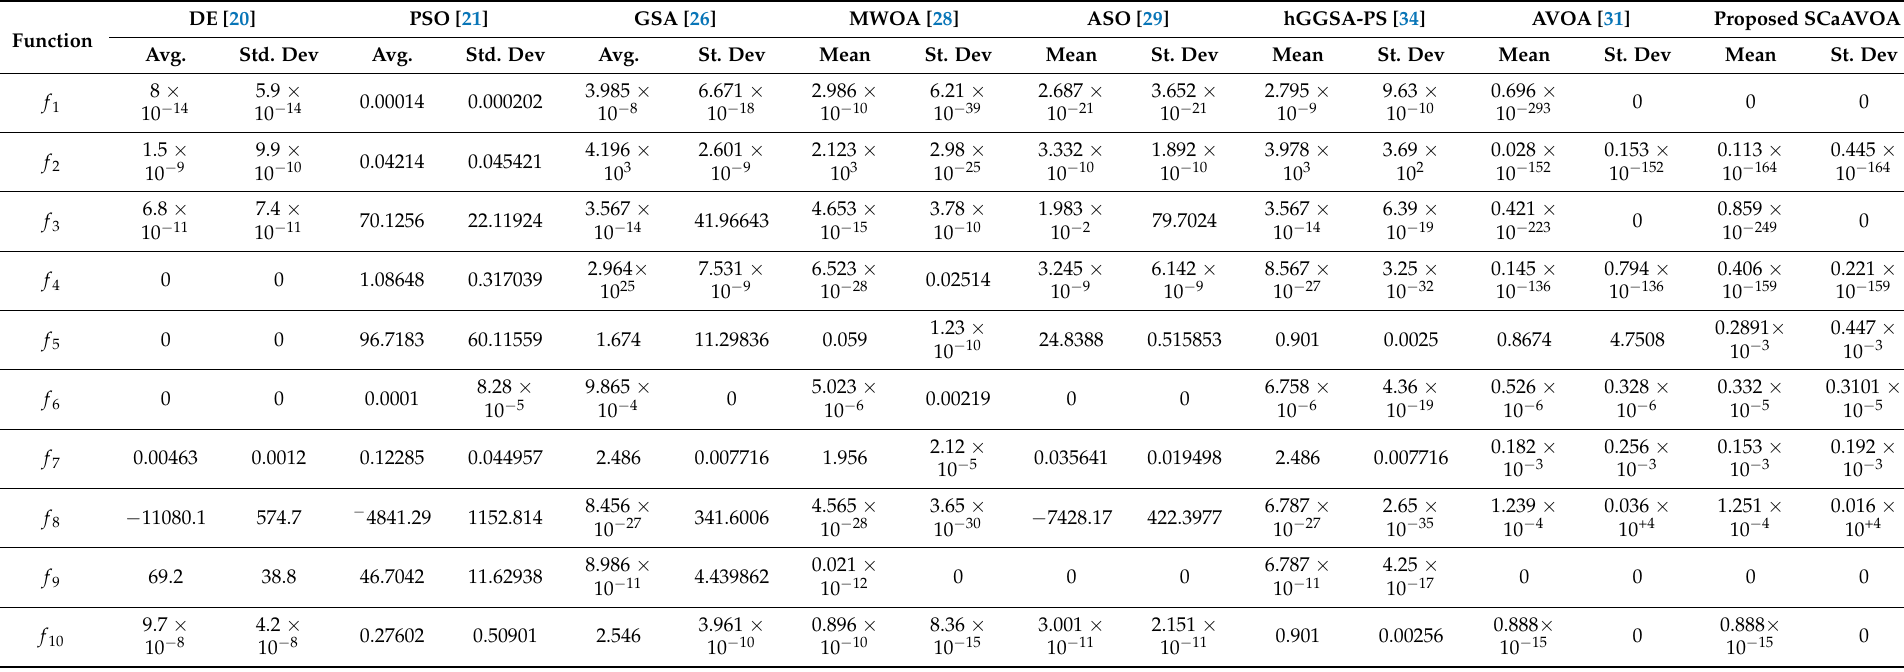
Table 2. Cost function comparison of the proposed SCaAVOA considering standard benchmark